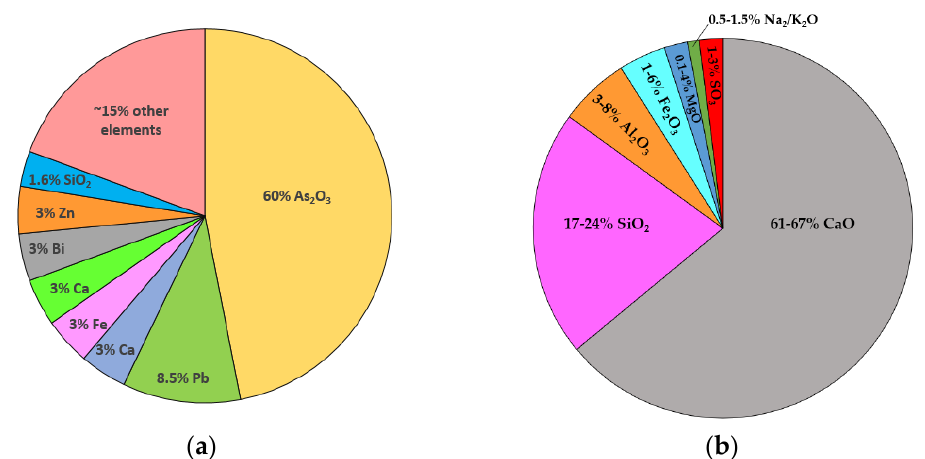
Figure 1. Chemical composition of ( a ) smelter high-arsenic flue dust and ( b ) type 10 ordinary Portland cement (OPC).